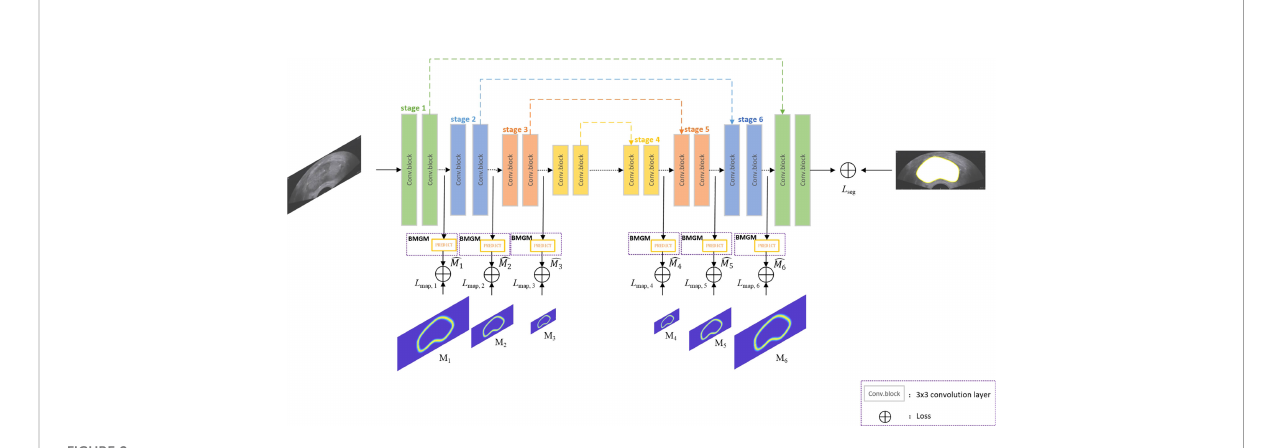
FIGURE 2 Overview of the proposed network